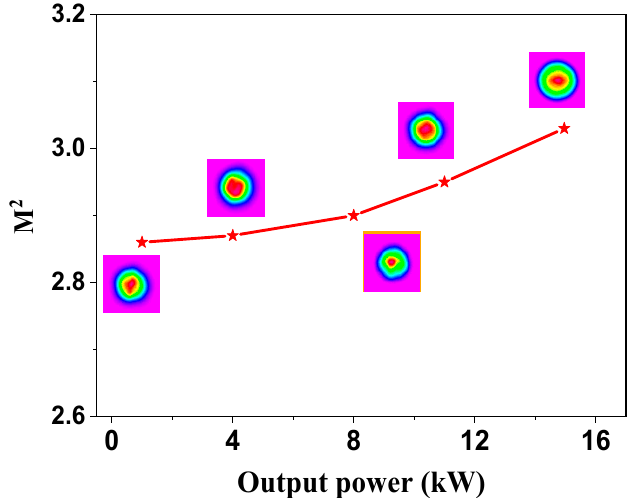
Figure 10. The M 2 value of the amplifier at different output power.